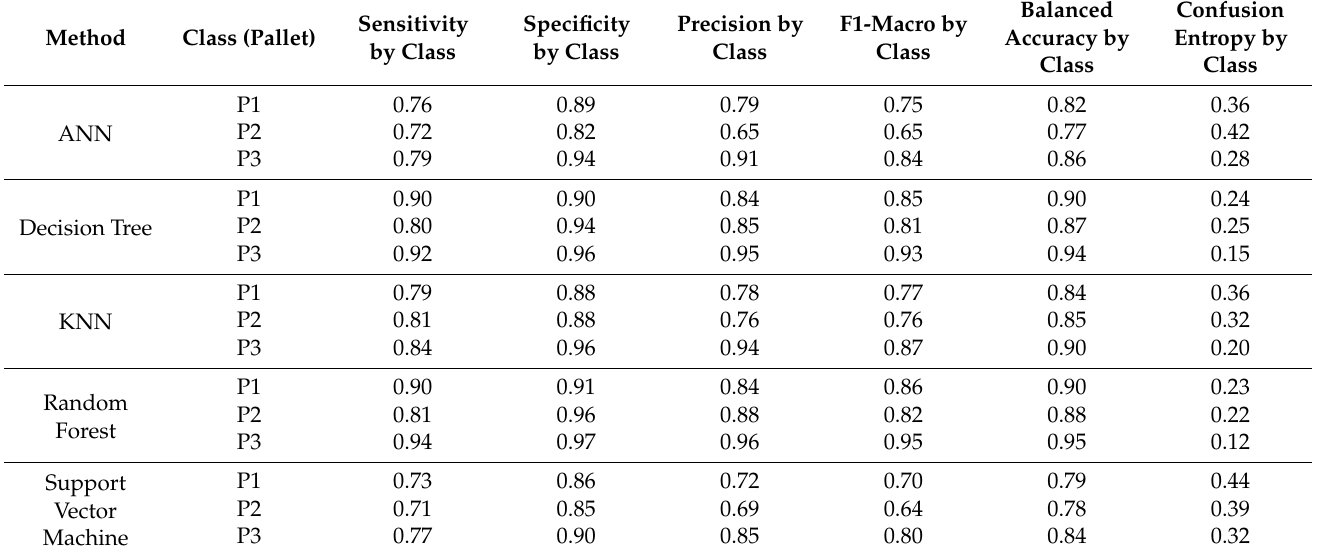
Table 4. Evaluation of the ANN, Decision Tree, KNN, Random Forest, and Support Vector Machine on the test dataset in terms of metrics by